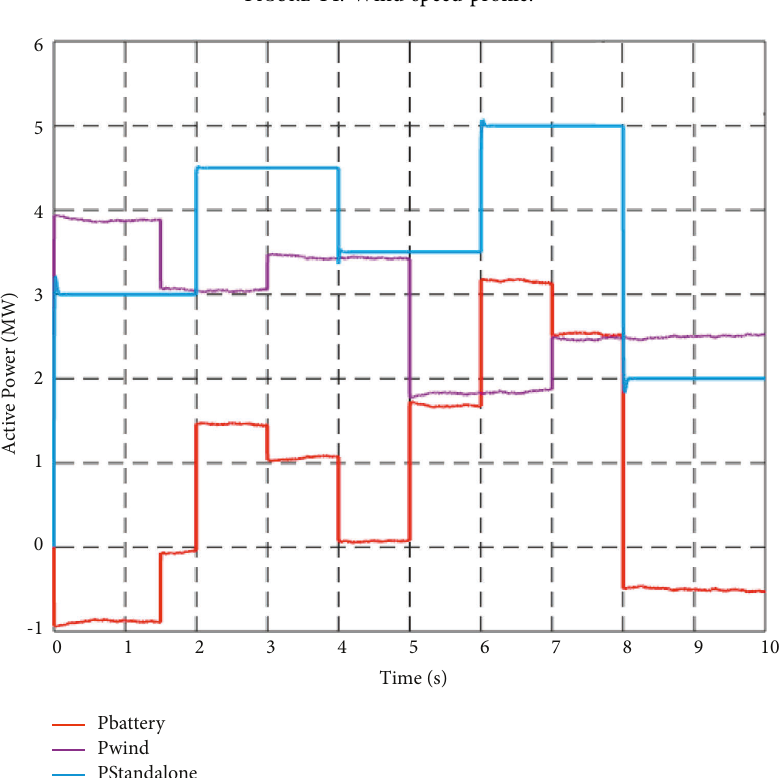
Figure 15: Dynamic response of power for standalone (wind turbine and